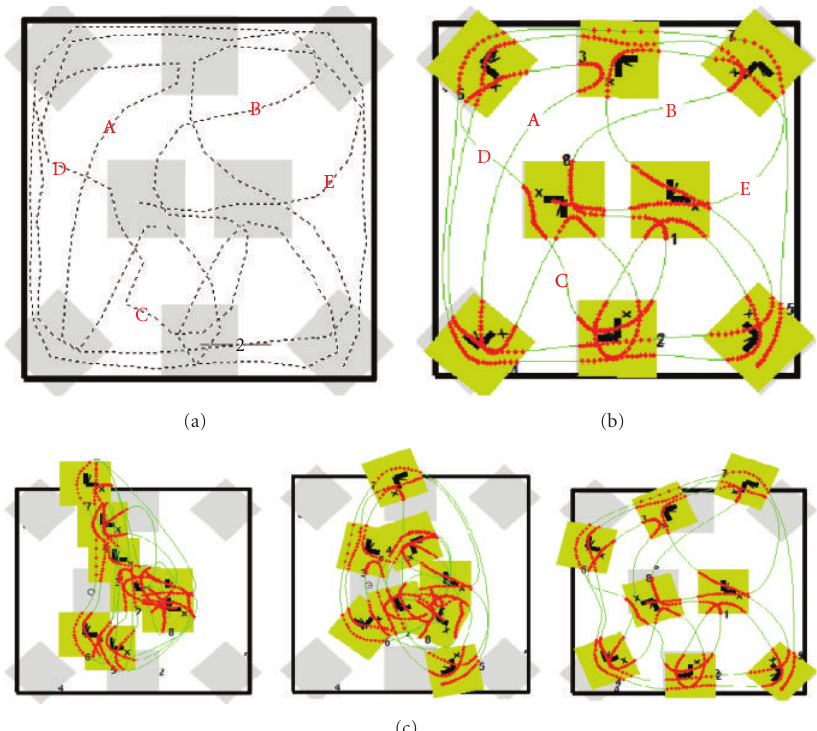
Figure 5: An example of localization of a camera network: (a) a network of cameras along with the original object trajectory (dash-line); (a–d) few nonlinear turns that object take in unobserved regions, (b) estimated trajectory and final localization results with the proposed algorithm, and (c) outputs at intermediate